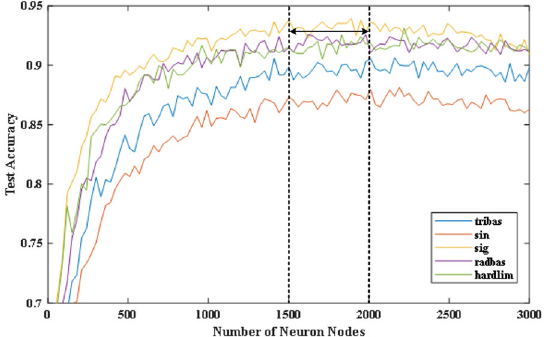
Fig. 8 Performance of single ELM classifier with different types of activation function